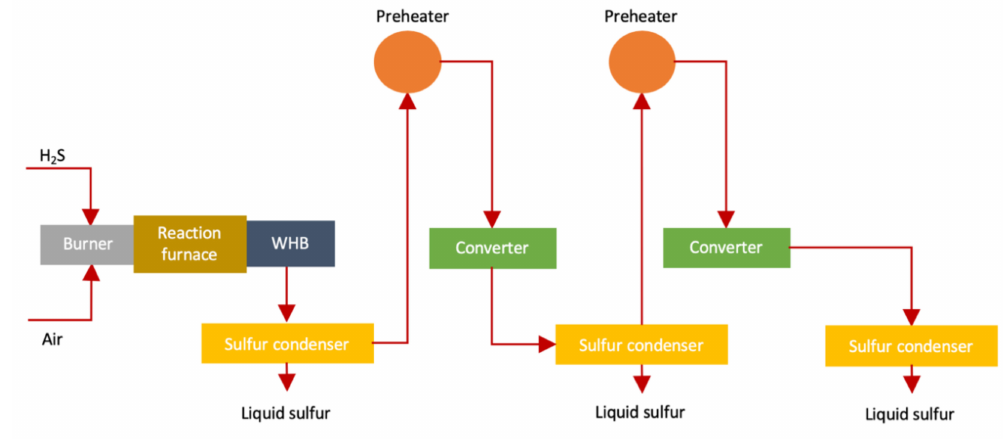
Figure 4. Claus process for sulfur production (adapted from Reference